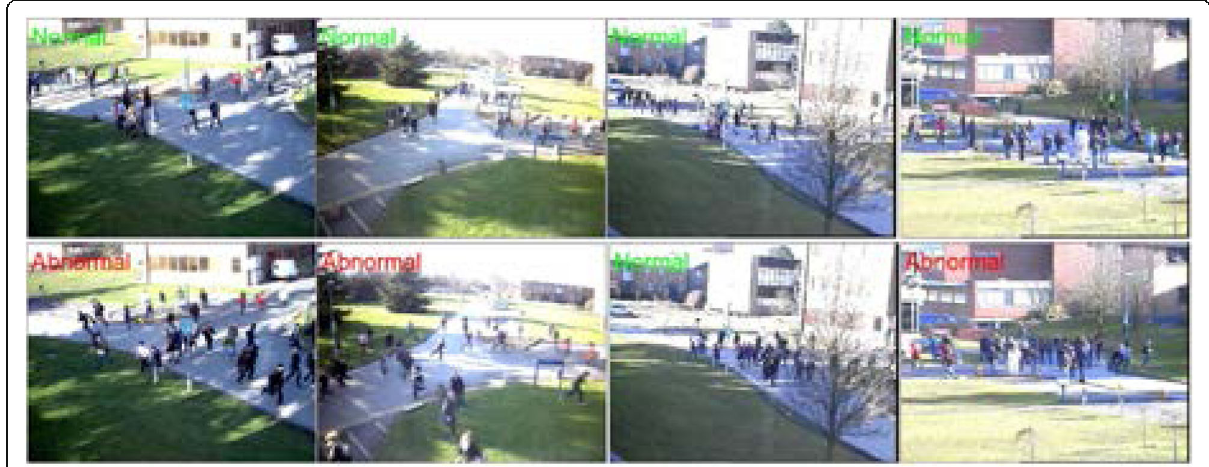
Fig. 9 Examples of detection results for global abnormality detection from the PETS2009 dataset